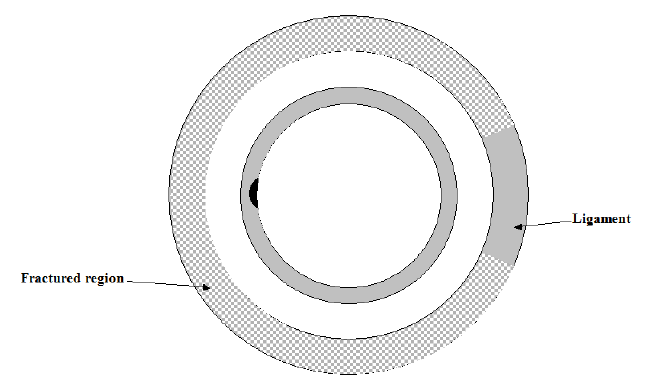
Figure 25: Stage-3 crack configuration.